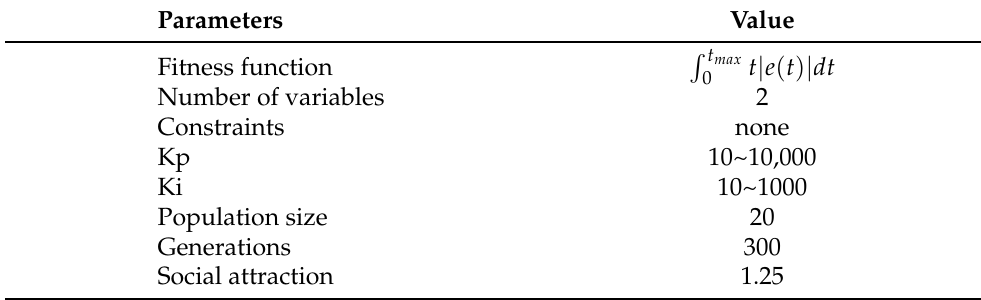
Table 5. Major parameters for the PSO process of step load change.